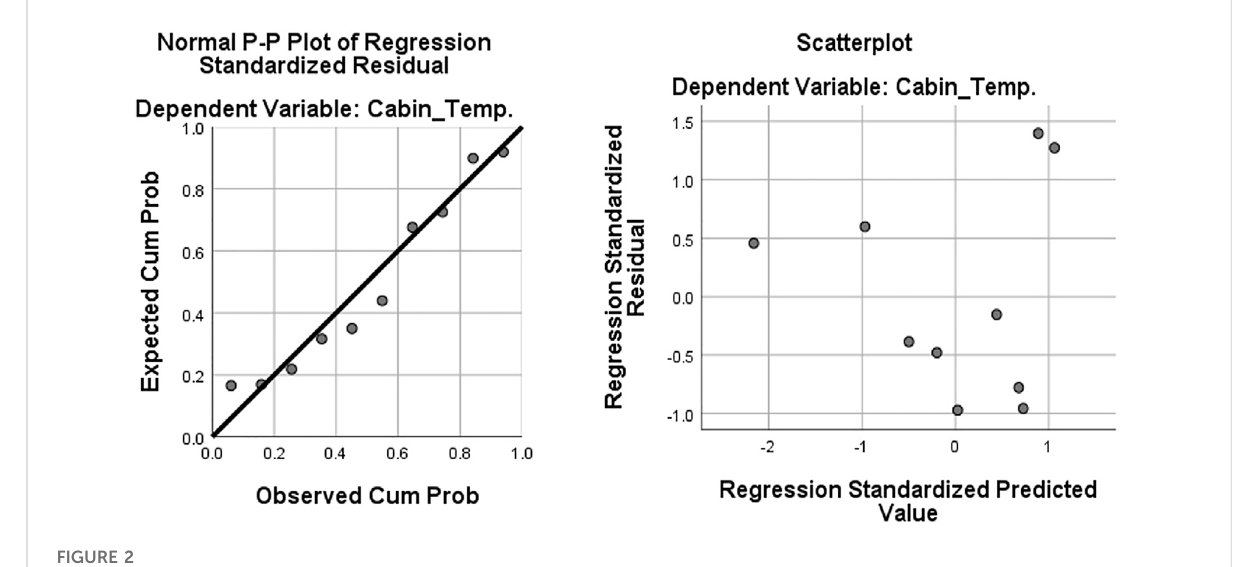
FIGURE 2 Normal P-P plot (left) and scatterplot (right).